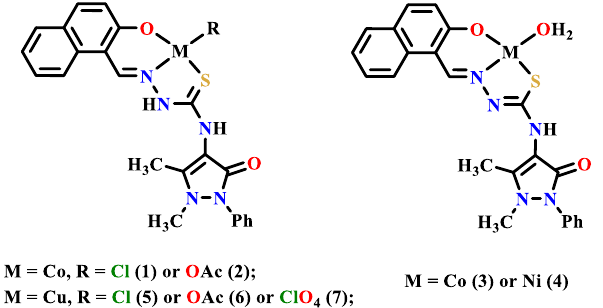
Figure 6. The Cu(II)/Co(II)/Ni(II) complexes of naphthylhydrazone with antipyrine-type side chain.